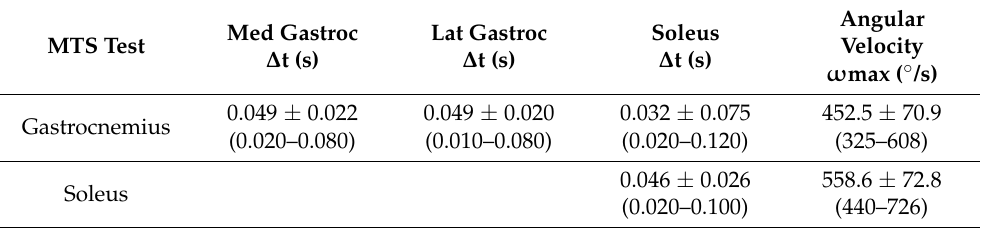
Table 1. Means standard deviation (range) of the delay ( ∆ t in seconds) from the Gastrocnemius medius, Gastrocnemius lateralis, and Soleus activation onset and maximum foot angular velocity during the Gastrocnemius and Soleus MTS assessments.